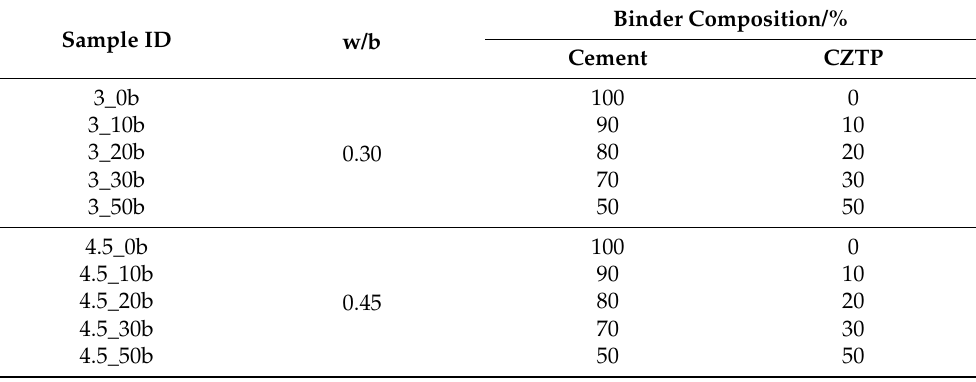
Table 3. Mix proportions of mortars.